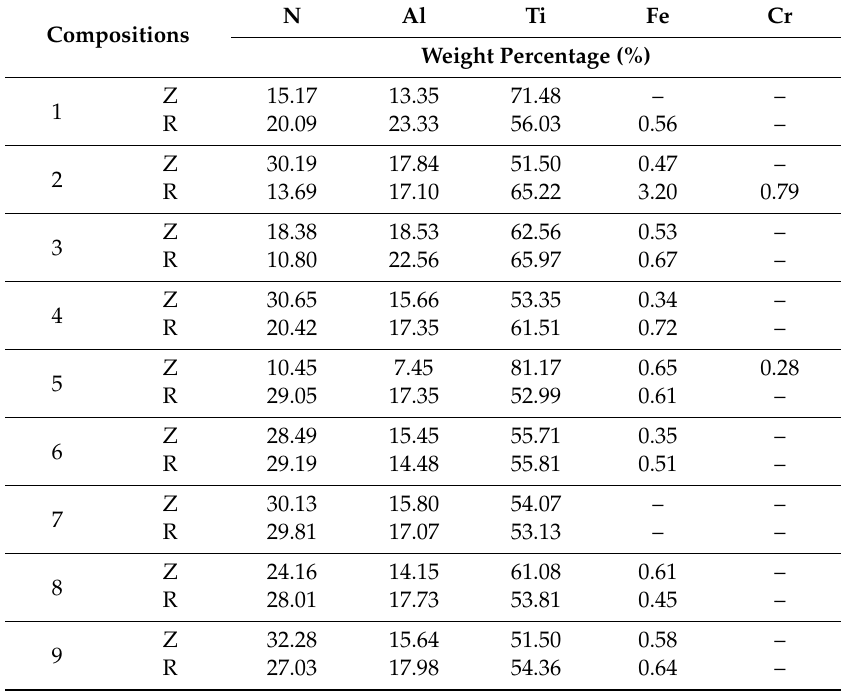
Table 2. Compositions of typical regions of coating specimens on energy dispersive X-ray spectroscopy (EDS) spectrums.